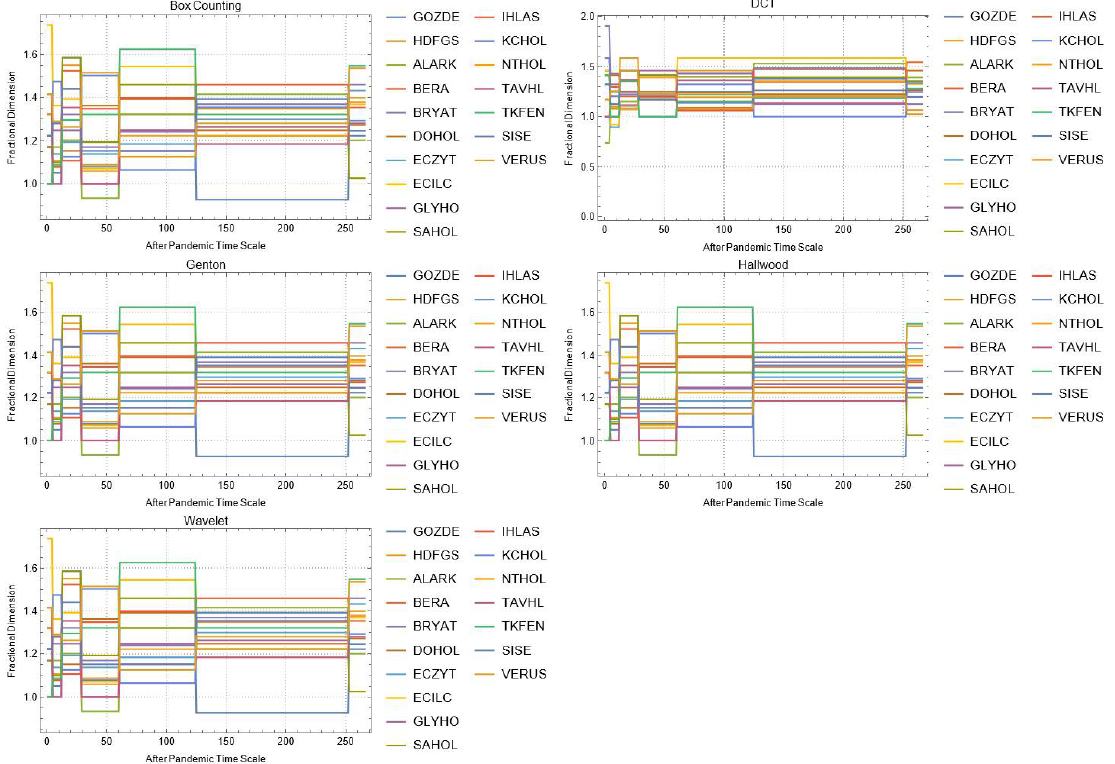
Figure A25. Daily changes of fractal dimensions after the pandemic (holdings–investment companies).